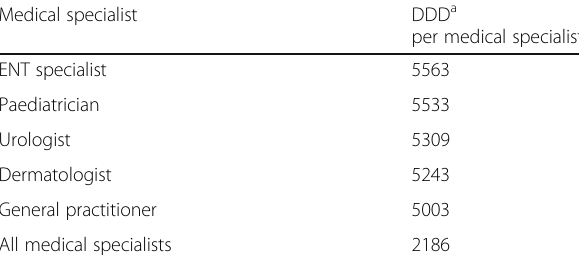
Table 1 Antibiotic prescriptions for Outpatients in Germany